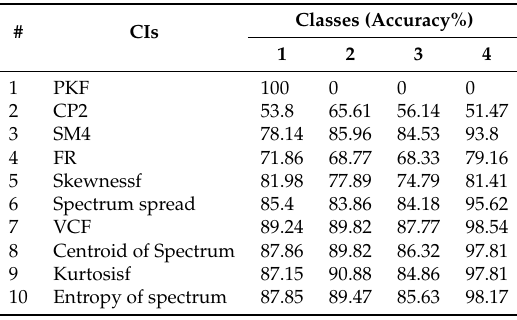
Table 6. Accuracy per class to CI_FL (frequency domain).